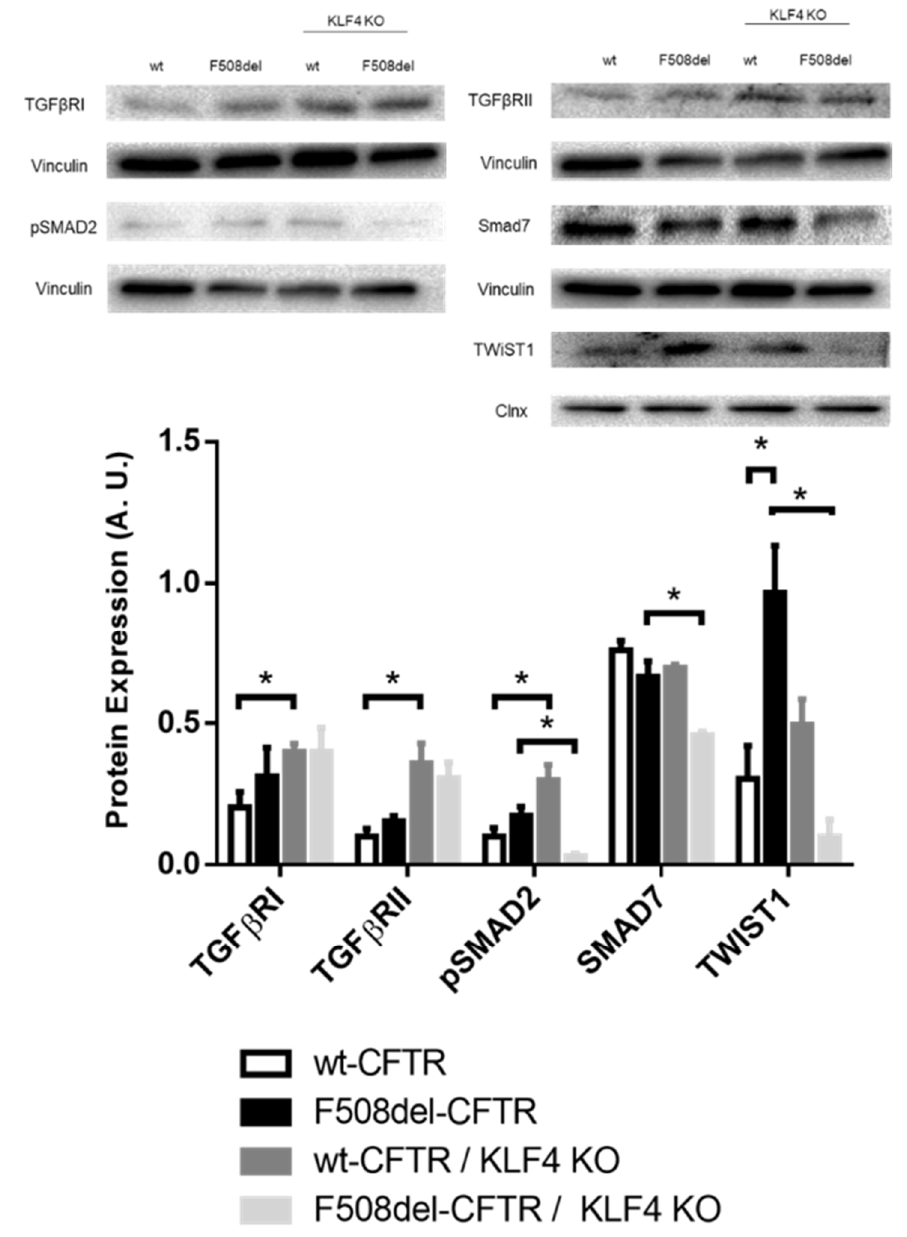
Figure 5. Impact of KLF4 KO on TGF β pathway proteins and TWIST1. Protein levels on wt- and F508del-CFTR CFBE and their respective KLF4 KO counterparts. Representative WB of TGF β RI, TGF β RII, pSMAD2, SMAD7, and TWIST1. Calnexin and vinculin were used as loading control. Data are normalized to loading control and showed as arbitrary units (A.U.; n = 3, unpaired t -test, * is p < 0.05).